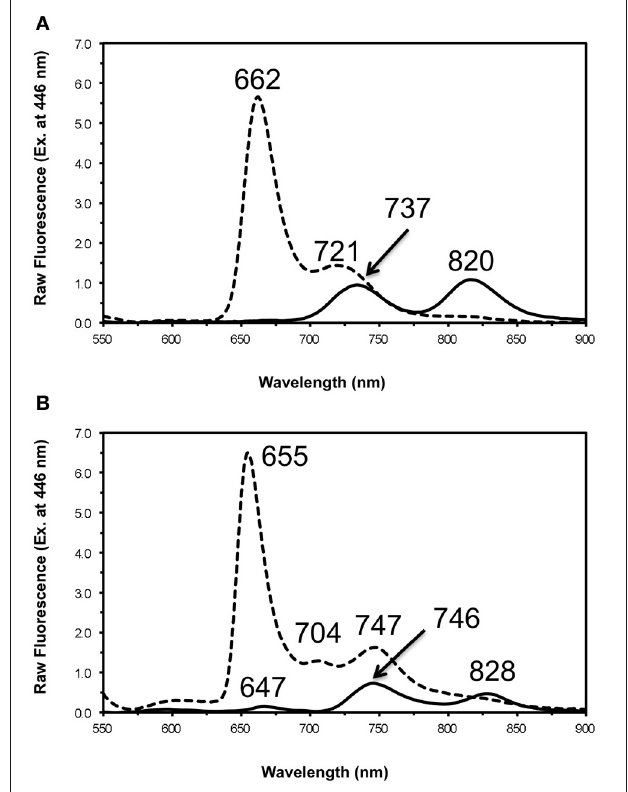
FIGURE 9 | Fluorescence emission spectra for chlorosomes from C. limnaeum WT at room temperature (panel A) and 77K (panel B). The excitation wavelength was 457nm for each. Spectra of oxidized chlorosomes (dotted lines) were recorded in air-saturated buffer. The spectra of reduced chlorosomes (solid lines) were recorded after treatment with 25mM sodium dithionite and incubation in the dark for 1h.